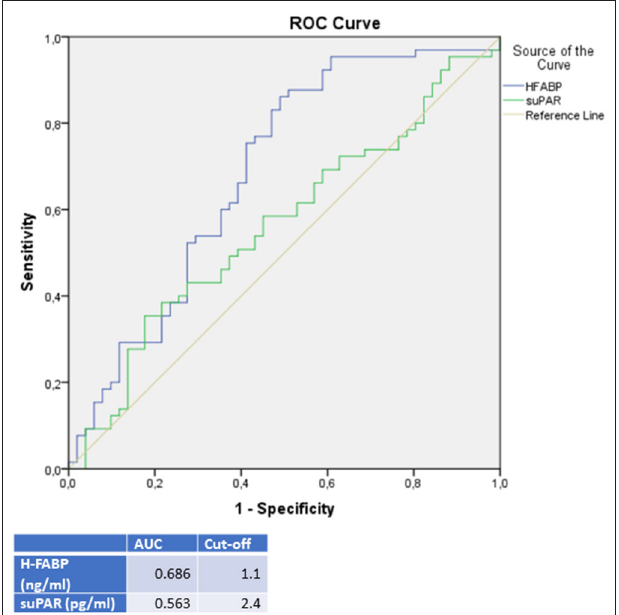
FIGURE 4 | ROC-Curves and cut off scores for H-FABP (HFABP) and suPAR for prediction of DCMP in the total cohort (including patients with DCMP and TTC).